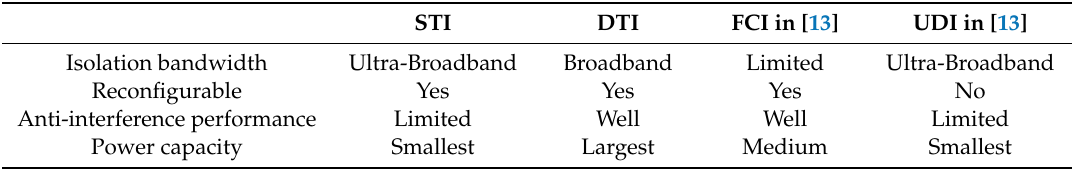
Table 1. The properties of the